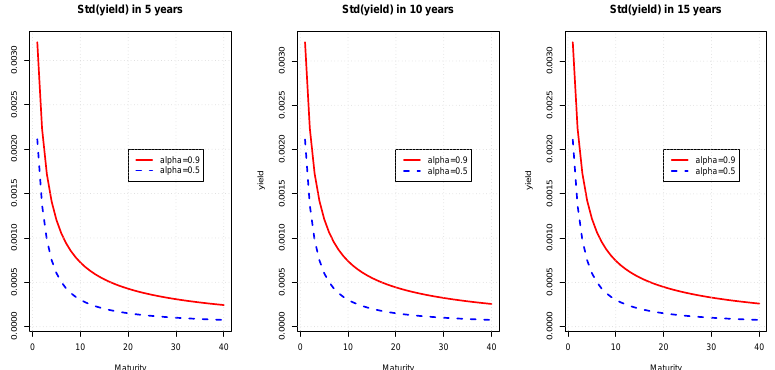
Figure 8. Expected standard deviations of yields in 5, 10 and 15 years; α = 0.5 and 0.9; β = 1.5; λ 1 = 0.5; η 1 = − 0.002; σ 1 = 0.01. PML kernel with n = 40